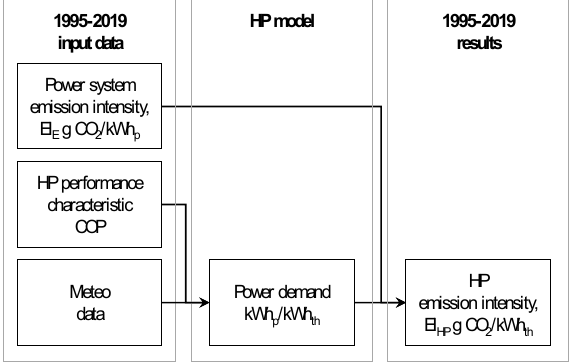
Figure 8. Information flow diagram for calculating the CO 2 emission intensities of heat pumps.